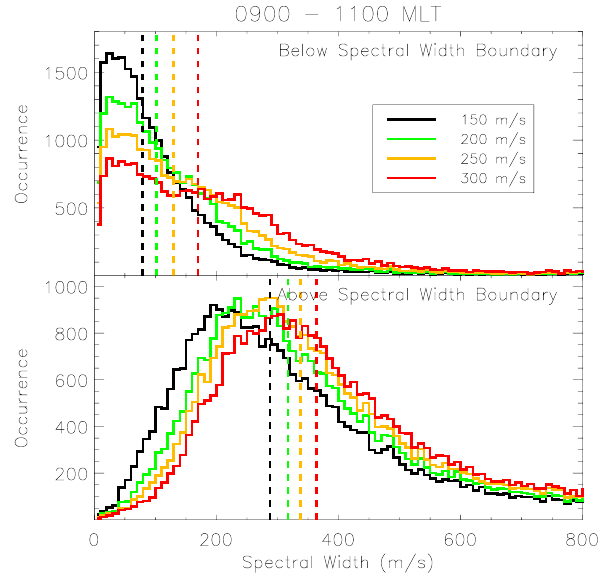
Fig. 6. The distribution of spectral width values below (equatorward of) and above (poleward of) the spectral width boundary determined by applying the C-F threshold technique to 5-years worth of spectral width data from beam 8 of the Halley SuperDARN radar. Only data from the 09:00–11:00 MLT region, and from within 10 range gates of the estimated boundary location, are shown. The four different histograms represent the results from using four different spectral width threshold values (150, 200, 250, and 300m/s) to identify the